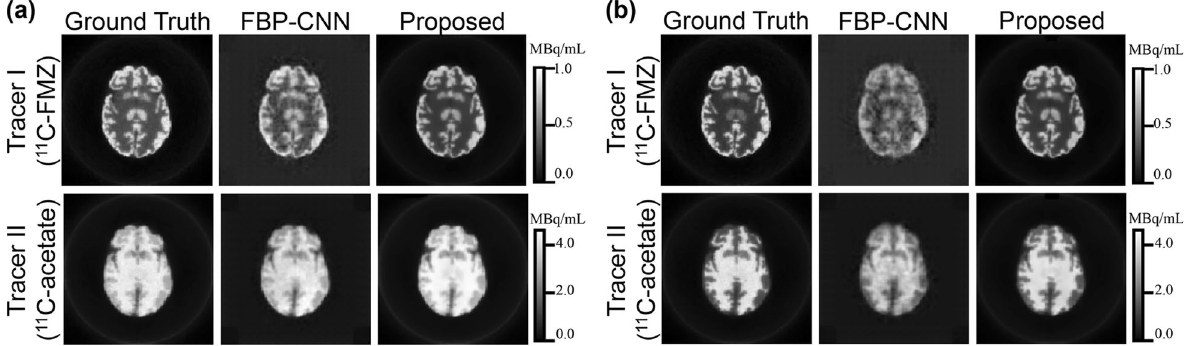
The lower MSE, higher MS-SSIM and higher PSNR are noted in bold font in the comparison of the proposed method and FBP-CNN